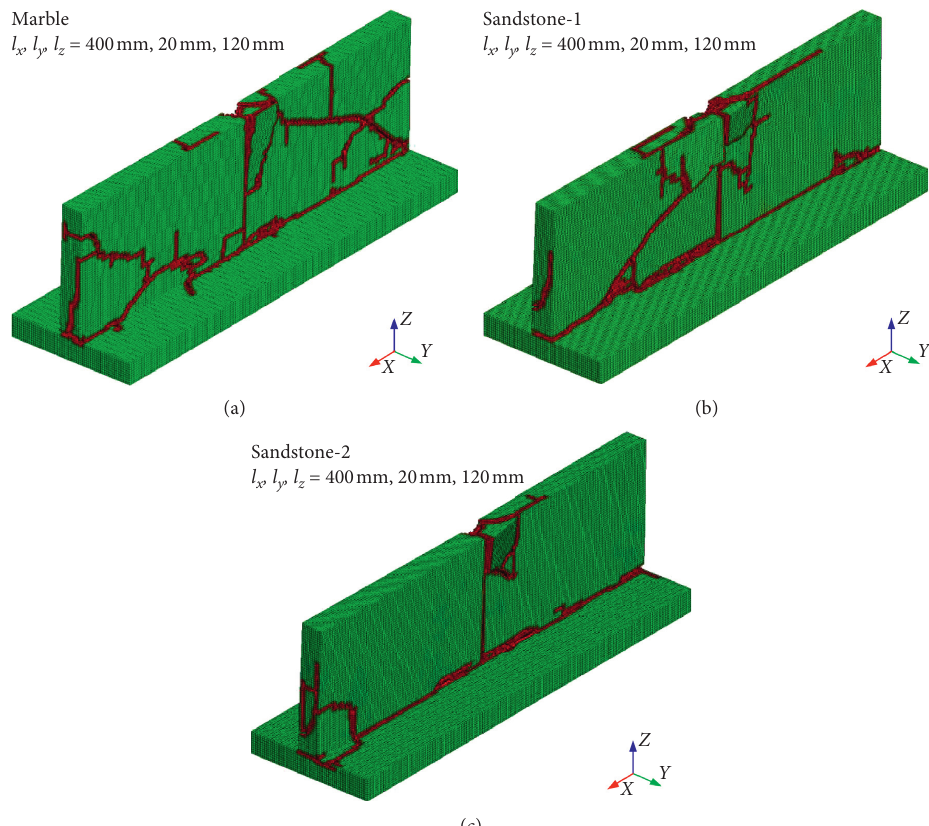
Figure 20: Cutting results of rock plates with rocks: (a) marble, (b) sandstone-1, and (c) sandstone-2.